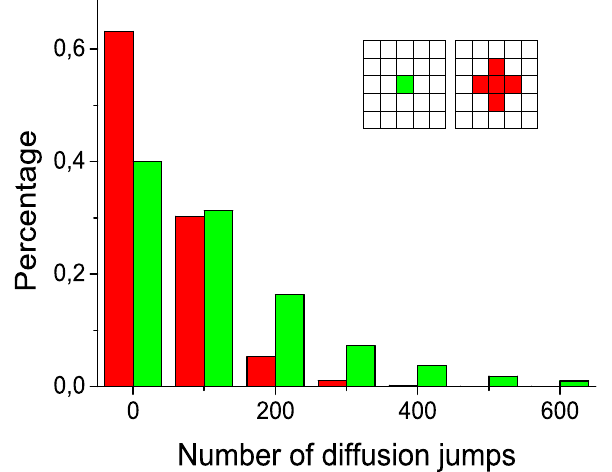
Figure 3. The histogram compares the numbers of diffusion jumps on 11 × 11 lattice that randomly adsorbed particle needs to reach the cluster in the centre; the cluster size is the only difference, one (green) or five (red) cites; averaged over 10 6 runs.